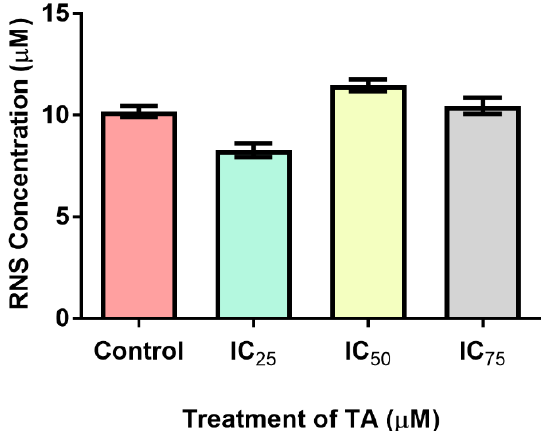
Figure 4. Nitrosative stress induced in Hek-293 cells based on varying TA treatments. Generation of RNS was non-significantly increased at IC 50 (12.5%) and IC 75 (2.6%), whilst a non-significant decrease occurred at IC 25 (18.7%) relative to the control. RNS: reactive nitrogen species.